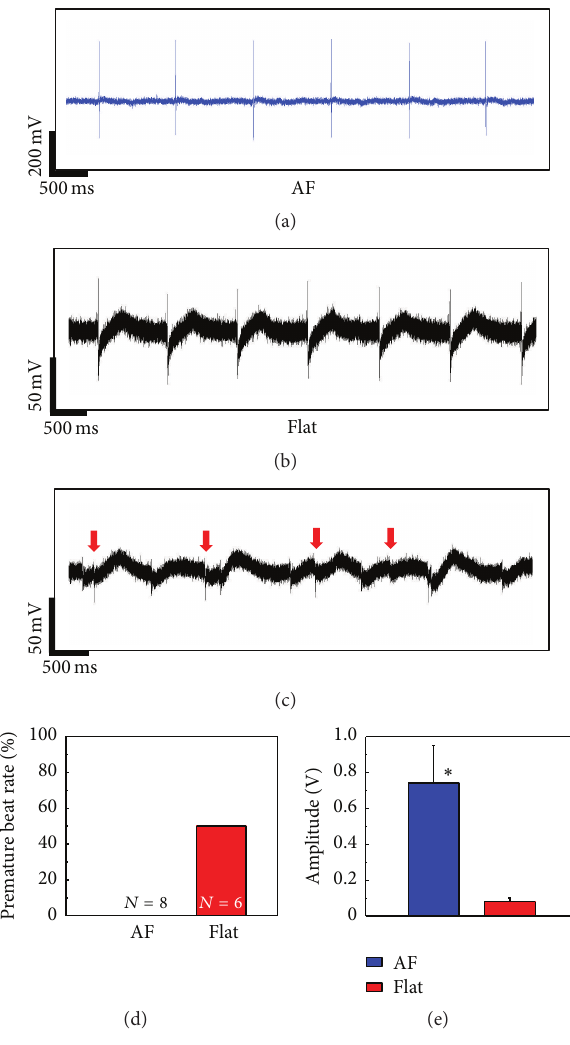
Figure 4: Extracellular recording of IMR hiPS-cardiomyocytes (CMs) by MEA at day 6. Spontaneous beatings of CMs on aligned fiber- (AF-) covered (a) and gelatin-coated (Flat) MEA (b) at day 6. (c) Premature beating recorded on Flat samples at day 6. The red arrows mark the representative beating of the premature beating. (d) Premature beating rate of samples at day 6. 𝑁 is the number of the respectivesamples.(e)AmplitudeoffieldpotentialrecordedonCMs at day 6 (means ± s.e., 𝑛 = 3 , ∗ 𝑃 < 0.05